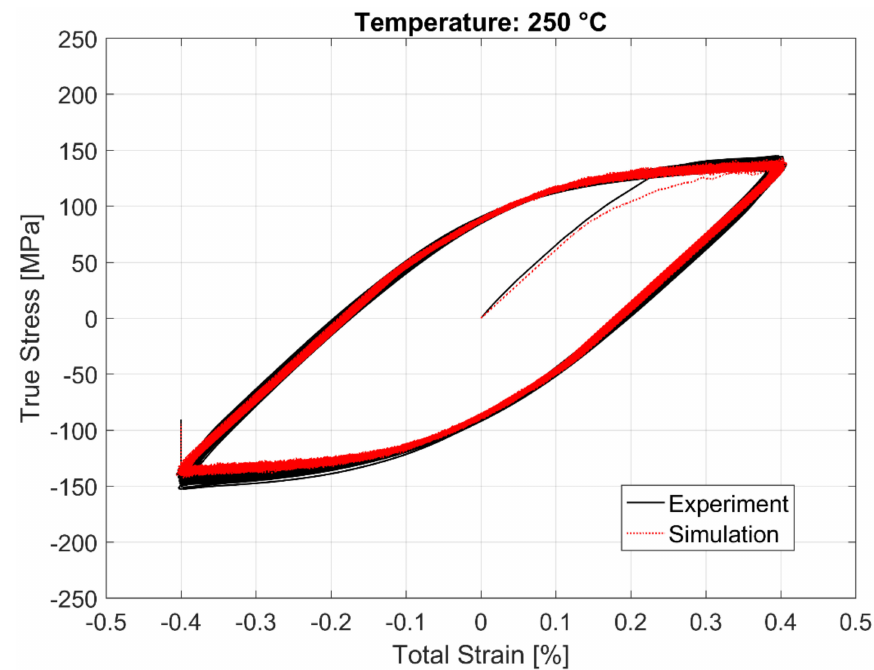
Figure 23. Experimental vs. visco-plastic model prediction at 250 ◦